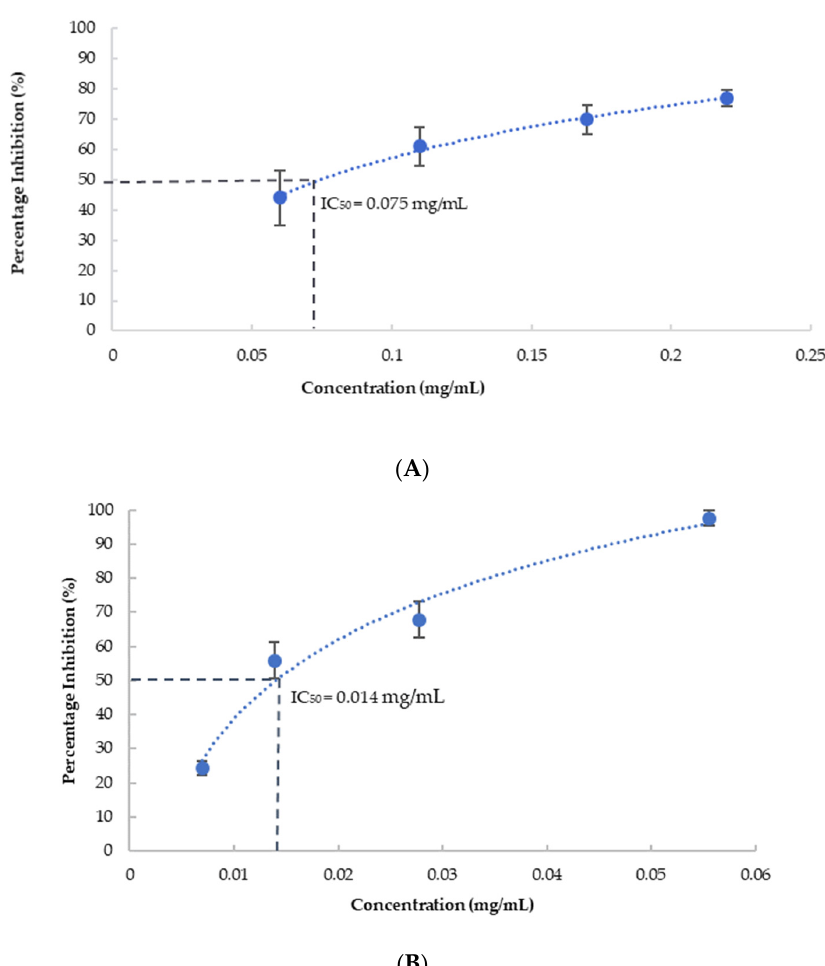
Figure 1. Percentage inhibition of cholinesterase by blueberry extract at various concentra- tions. ( A ): The inhibition of AChE; ( B ): The inhibition of BuChE. Values are presented as the mean ± Standard Deviation (SD) of n =